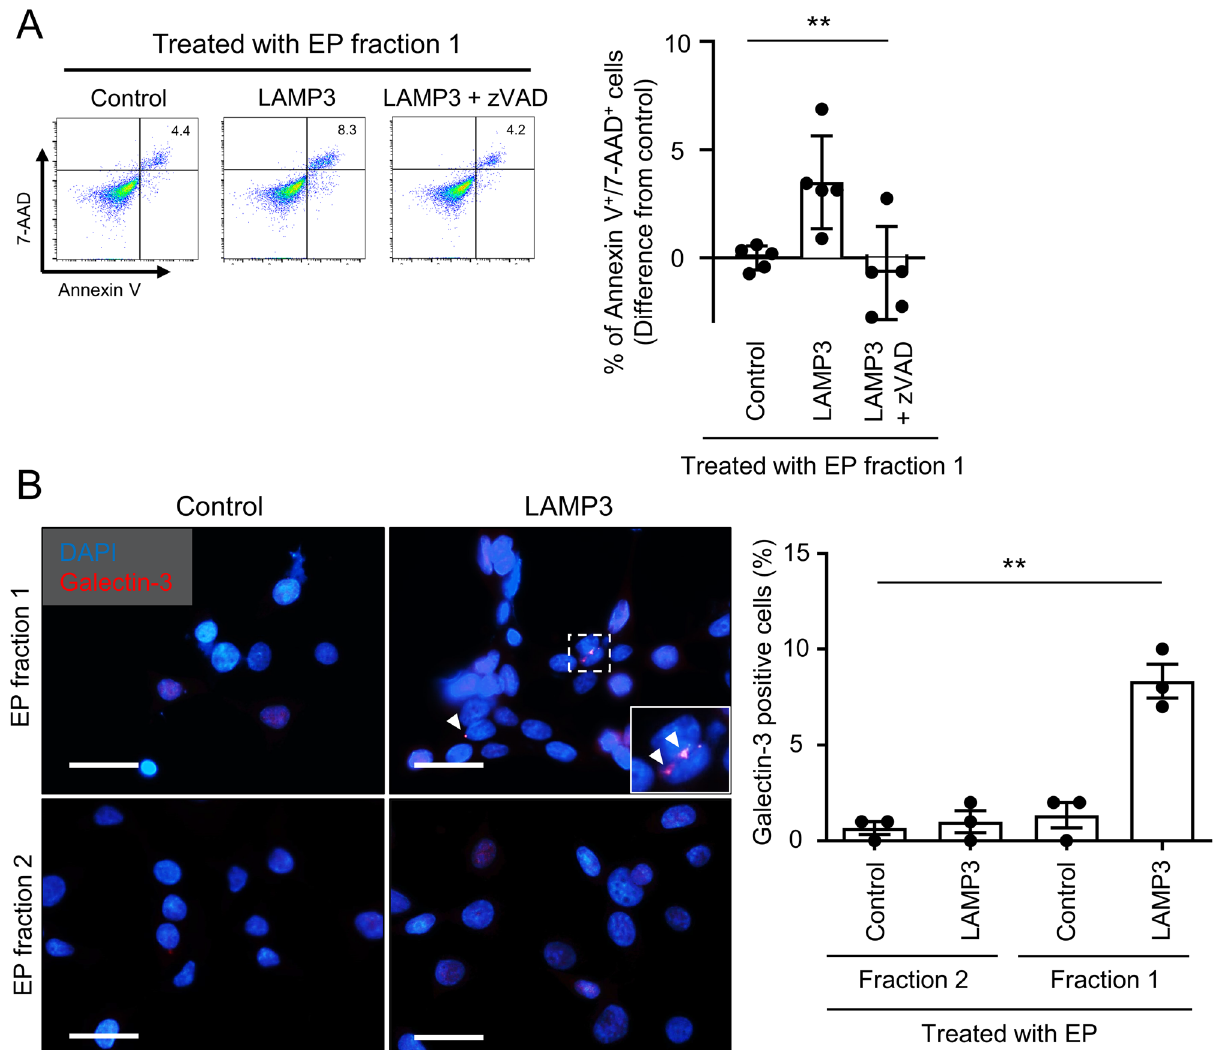
Figure 7. LAMP3 transfer via extracellular particles induces caspase-dependent apoptosis. ( A ) Naïve A253 cells were treated with EPs from control and LAMP3-overexpressing A253 cells in combination with or without zVAD-fmk (zVAD), a pan-caspase inhibitor. Apoptotic cells were determined by flow cytometry using APC Annexin V/7-AAD 72 h after incubation. Graph showing difference in mean (± SD) number of Annexin V + /7- AAD + cells in naïve A253 cell culture compared with control ( n = 5). ( B ) Naïve A253 cells were treated with EPs from control and LAMP3-overexpressing A253 cells for 6 h. Galectin-3 puncta formation in treated A253 cell culture was visualized by immunofluorescence (scale bar: 50 μm). Graph showing percentage of galectin-3 puncta–positive cells per 100 treated A253 cells ( n = 3). ** p < 0.01 (one-way